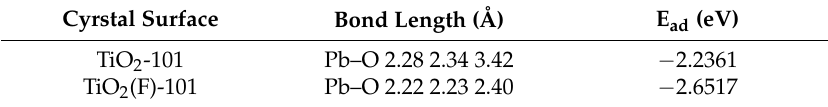
Figure 9. Side views of the optimized adsorption configurations of Pb(II) on ( a ) TiO 2 and ( b ) F–TiO 2 nanosheets exposed (101) facets. Table 1. Adsorption energy and bond length of Pb(II) adsorbed on TiO 2 and F–TiO 2 .